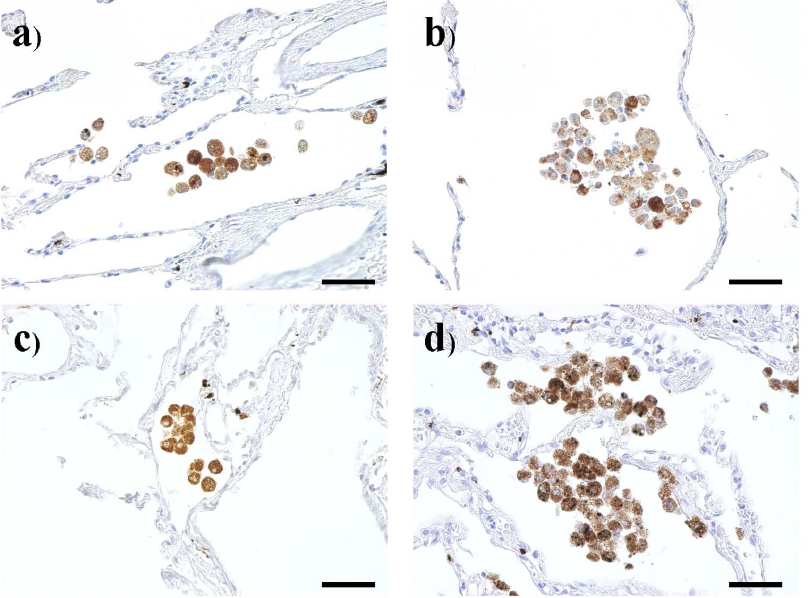
Figure 1. CD68 immunohistochemical staining of lung tissue samples from a) a non-smoker, b) a smoker, c) a mild chronic obstructive pulmonary disease patient (COPD), and d) a very severe COPD. Bar: 50 m